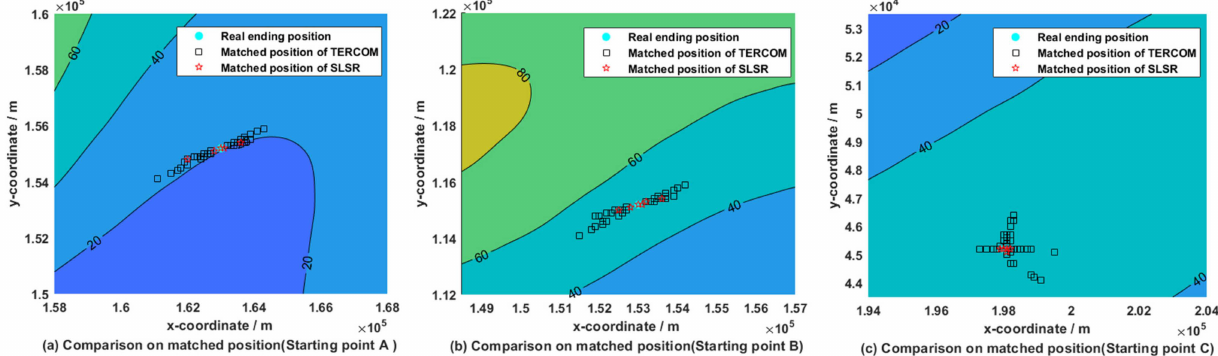
Figure 10. Matching dispersed comparison for out-of-domain matching points in different gravity